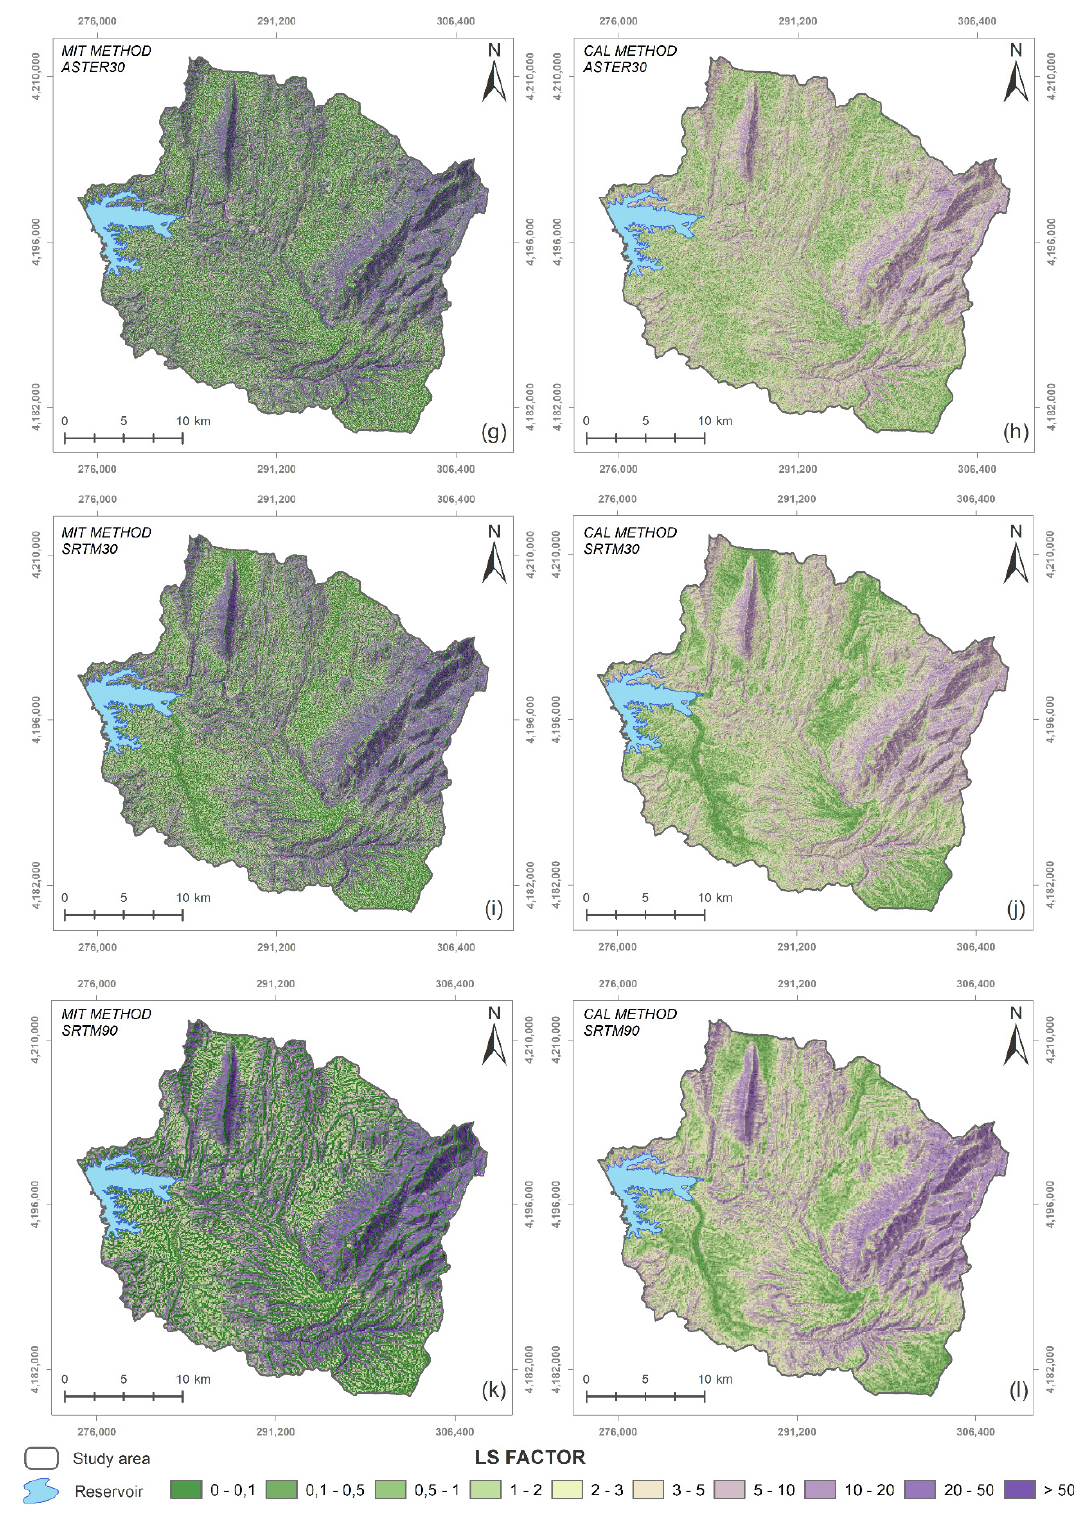
Figure A5. Maps of LS factor calculated with the MIT method applied on ASTER30 ( g ), SRTM30 ( i ), and SRTM90 ( k ) as well as the CAL method based on ASTER30 ( h ), SRTM30 ( j ), and SRTM90 ( l ).